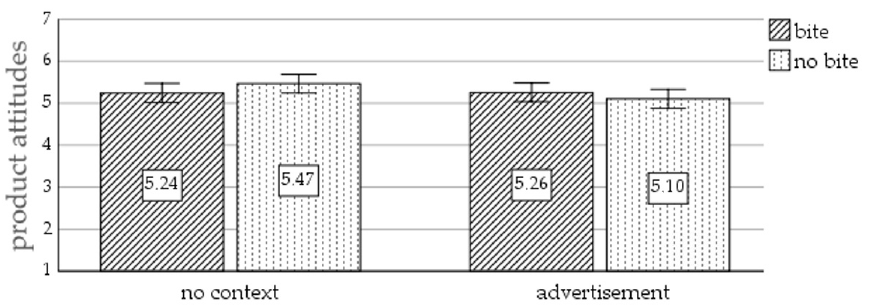
Figure 4. Results of Study 2. The interaction of picture type and context on product attitudes. Note: error bars represent 95% confidence interval.